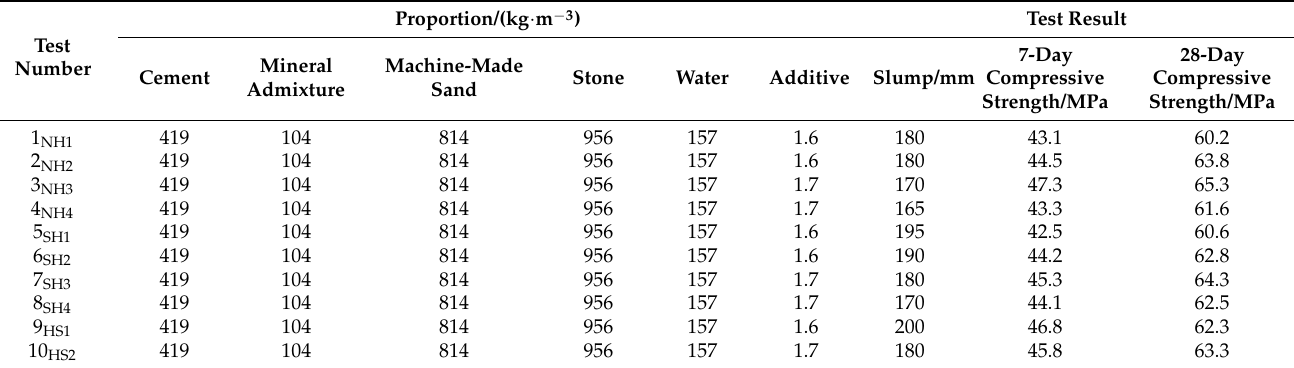
Table 10. Test mix ratio and test